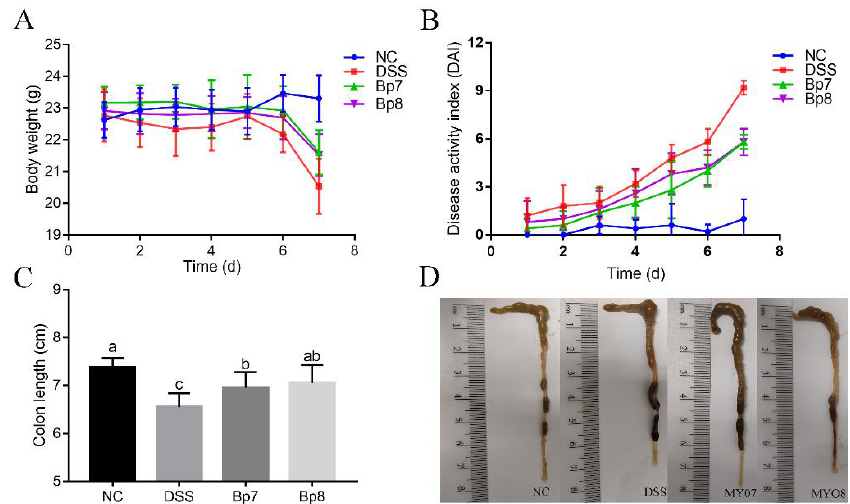
Figure 1. Influence of Bp7 and Bp8 intervention on body weight (A), disease activity index (DAI) (B), colon length (C), and representative pictures of colons in colitis mice (D) ( n = 8). The different letters represent significant differences between different experimental groups ( p < 0.05).